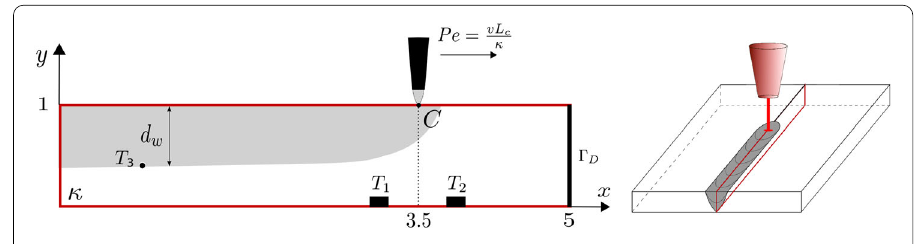
Fig. 2 Illustration of the considered welding